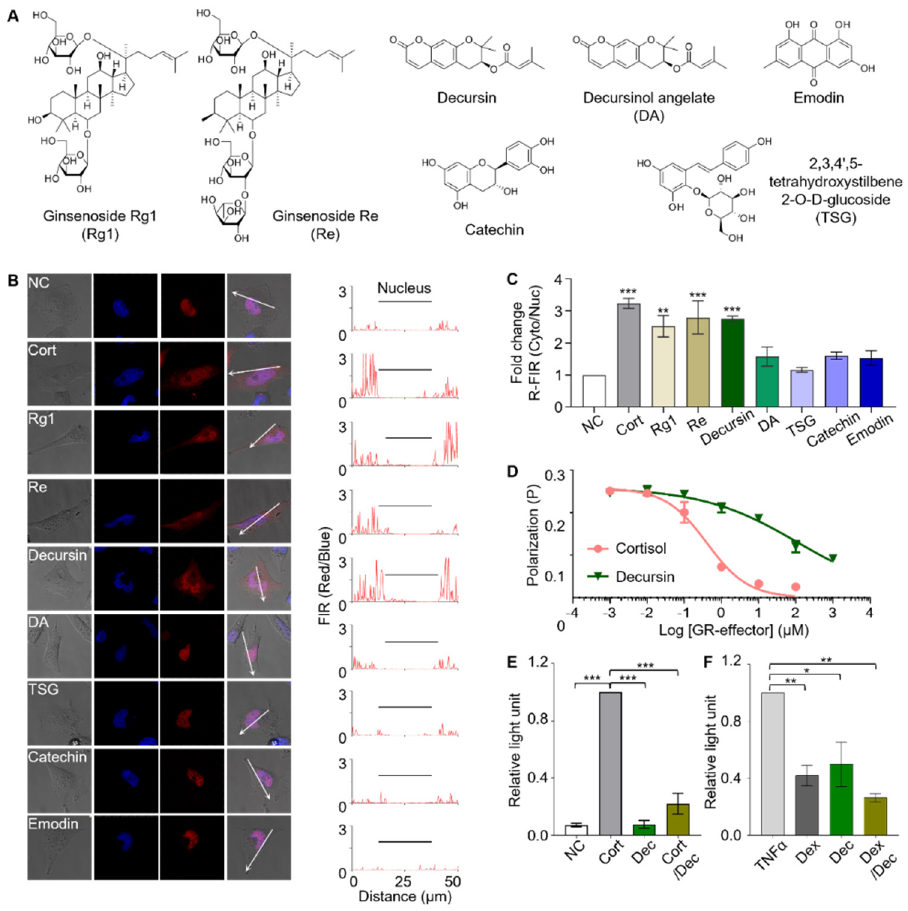
Figure 6. Screening the major components of ginseng, dongquai, and hasuo using sensor cells to identify GR effectors. ( A ) Structures of the major components in ginseng, dongquai, and hasuo. Rg1 and Re are components of ginseng, decursin and decursinol angelate (DA) are components of dongquai, 2,3,4 ′ ,5-tetrahydroxystilbene 2-O-D-glucoside (TSG), catechin, and emodin are components of Hasuo. ( B ) The sensor cells were challenged with seven major components derived from medicinal plants; they responded to Rg1, Re, and decursin (scale bar = 20 µ m). ( C ) Fold change in the ratio of red fluorescence intensity from the cytoplasm to that of the nucleus (R-FIR Cyto/Nuc) over untreated control sensor cells is calculated. Data were analyzed by one-way ANOVA using the Tukey multiple comparison test (* p < 0.05, ** p < 0.01). ( D ) In vitro competitive binding assay demonstrating that decursin binds to GR with much lower affinity than that of cortisol. ( E ) Glucocorticoid response element (GRE)-mediated transactivation study revealed that decursin does not activate GRE-mediated transactivation. ( F ) The NF- κ B-mediated trans-repression study revealed that decursin plays a role in NF- κ B-mediated trans-repression (* p < 0.05, ** p < 0.01, *** p <